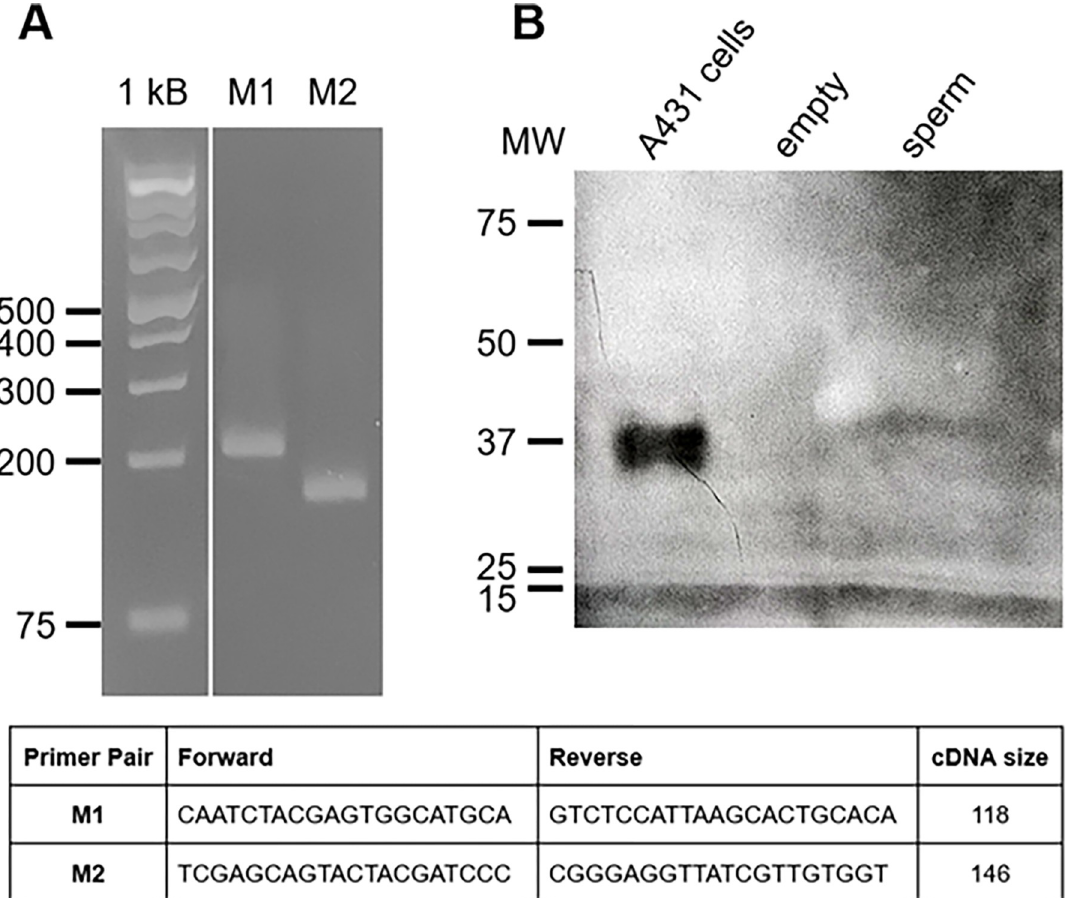
Fig 3. PCR and Western blot identification of MAPK. A) PCR analysis of testis cDNA for MAP Kinase. The primers used and predicted amplicon sizes are shown below the gel. B) Erk1/2 Western blot of Culex sperm. Using a polyclonal anti-Erk antibody, a band was detected in Culex tissues at approximately 42 kDa, consistent with migration of the positive control band from an EGF-stimulated A431 cell lysate.